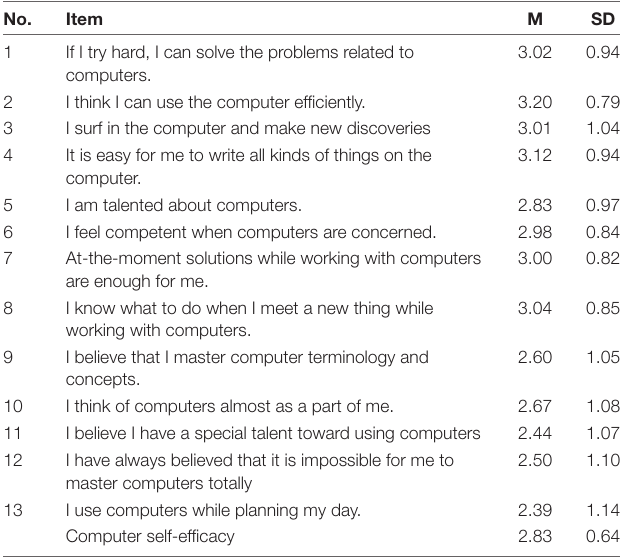
TABLE 2 | Distribution of answers of the computer self-efficacy scale ( N = 83).